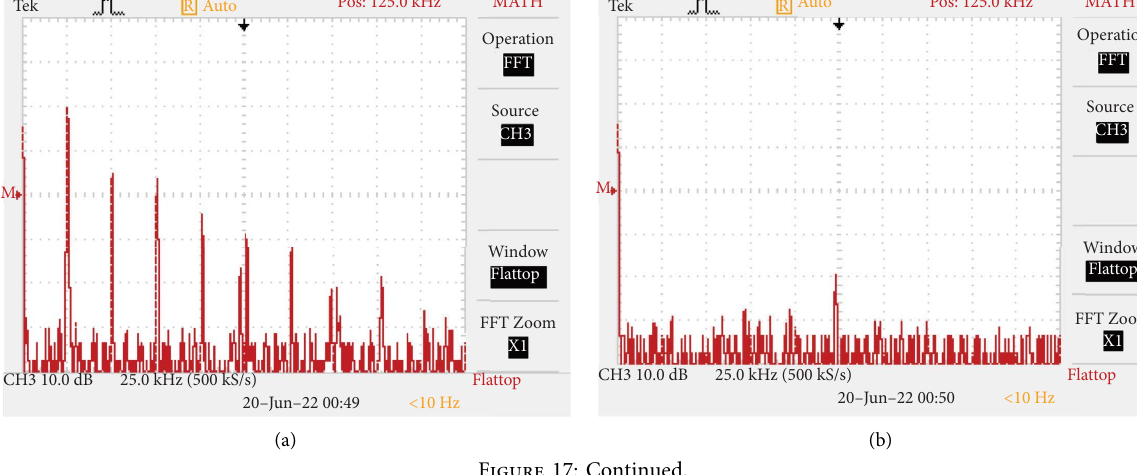
in , I L 1 , and V o ; (b) PWM, V in , I in , and V o (c) PWM, V in , I o , and V o LC flter with series damping.